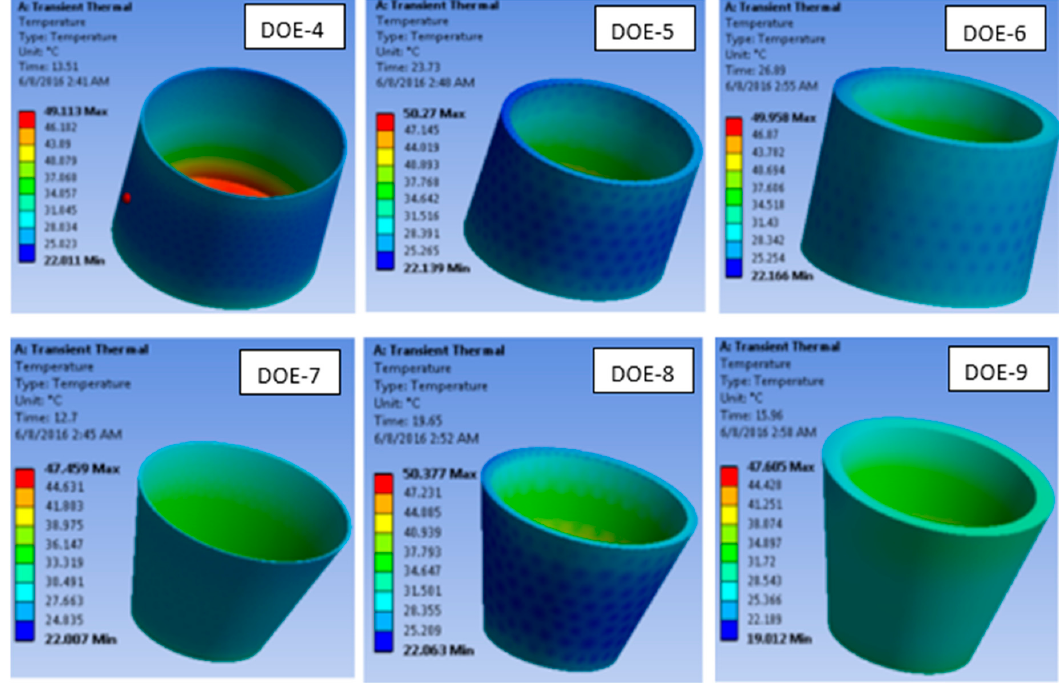
Figure 10. Temperature distribution on plastic parts for optimal design cases in DOE 4, 5, 6, 7, 8 and 9.